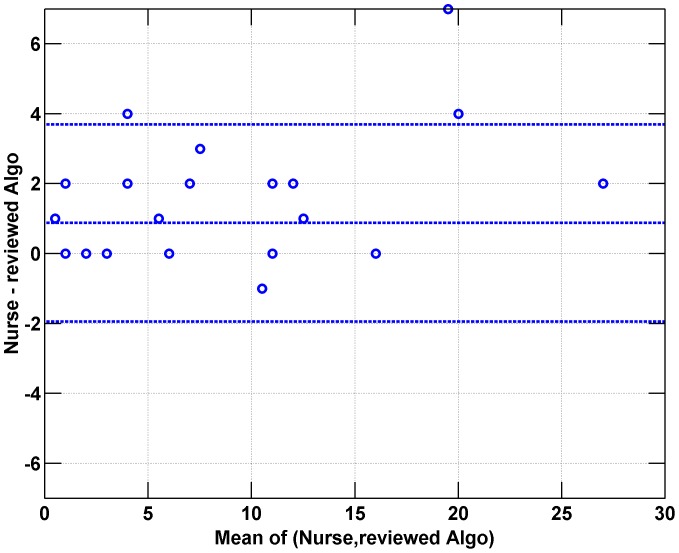
Bland-Altman plot comparing the number of epochs (definition epoch1) found by the nurses and the reviewed algorithm (i.e. semi-automated approach).The mean of the two estimates (used in place of a gold standard) is plotted vs. the difference between nurse and semi-automated results. The mean bias and limits of agreement (+/−1.96 σ) are also shown. The plot shows the bias is not statistically significant and there is no evidence of changing agreement as a function of cough epoch count.